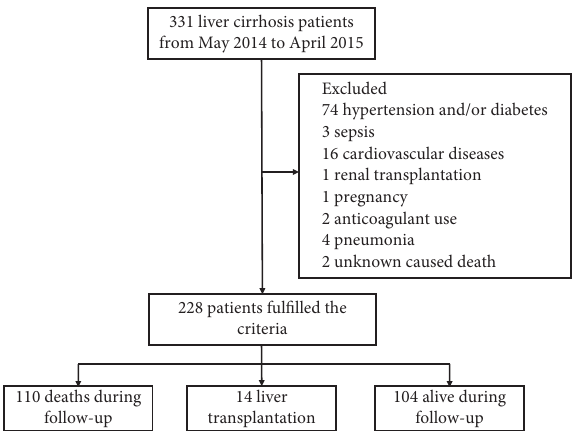
Figure 1: Flowchart of patient selection. 228 patients from 331 patients with liver cirrhosis (LC) were enrolled according to the criteria in this study, which were divided into three groups in- cluding deaths during follow-up, liver transplantation, and alive during